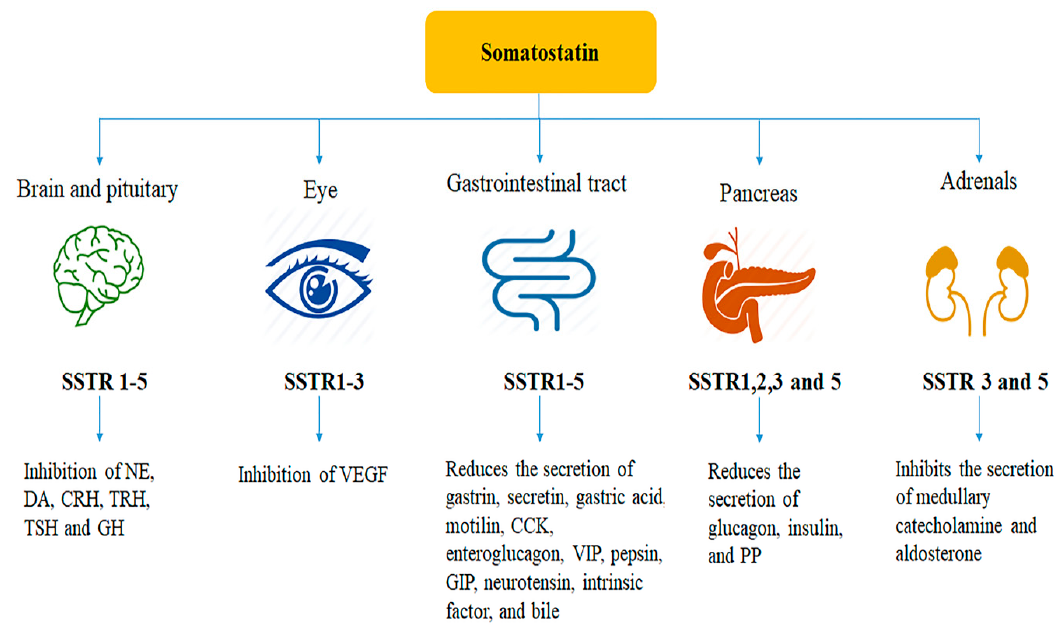
Figure 2. Schematic presentation showing somatostatin receptors associated with di ff erent roles of somatostatin in peripheral tissues. CCK, cholecystokinin; CRH, corticotropin releasing hormone; DA, dopamine; GH, growth hormone; GIP, gastric inhibitory polypeptide; NE, norepinephrine; PP, pancreatic polypeptide; TRH, thyrotropin releasing hormone; TSH, thyroid-stimulating hormone; VEGF, vascular endothelial growth factor; VIP, vasoactive intestinal peptide.